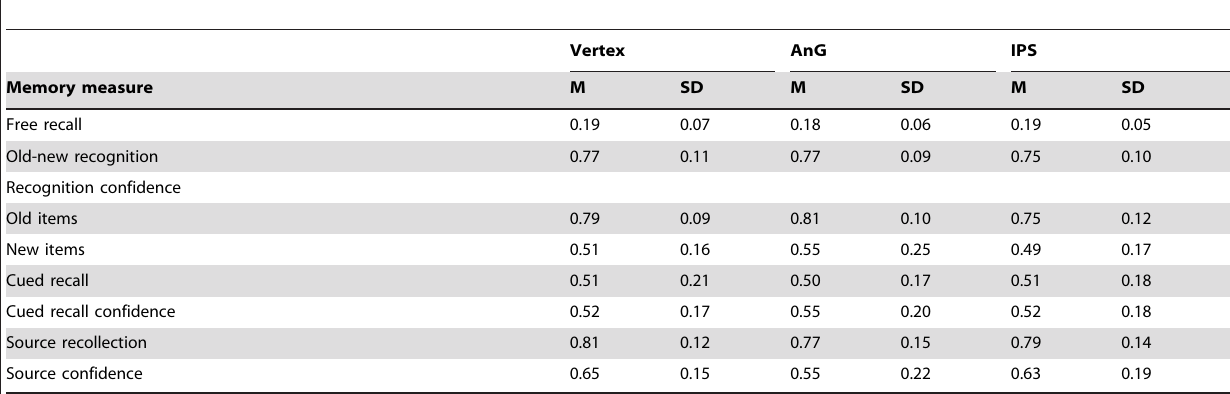
Table 1. Performance of the three participant groups on the battery of memory